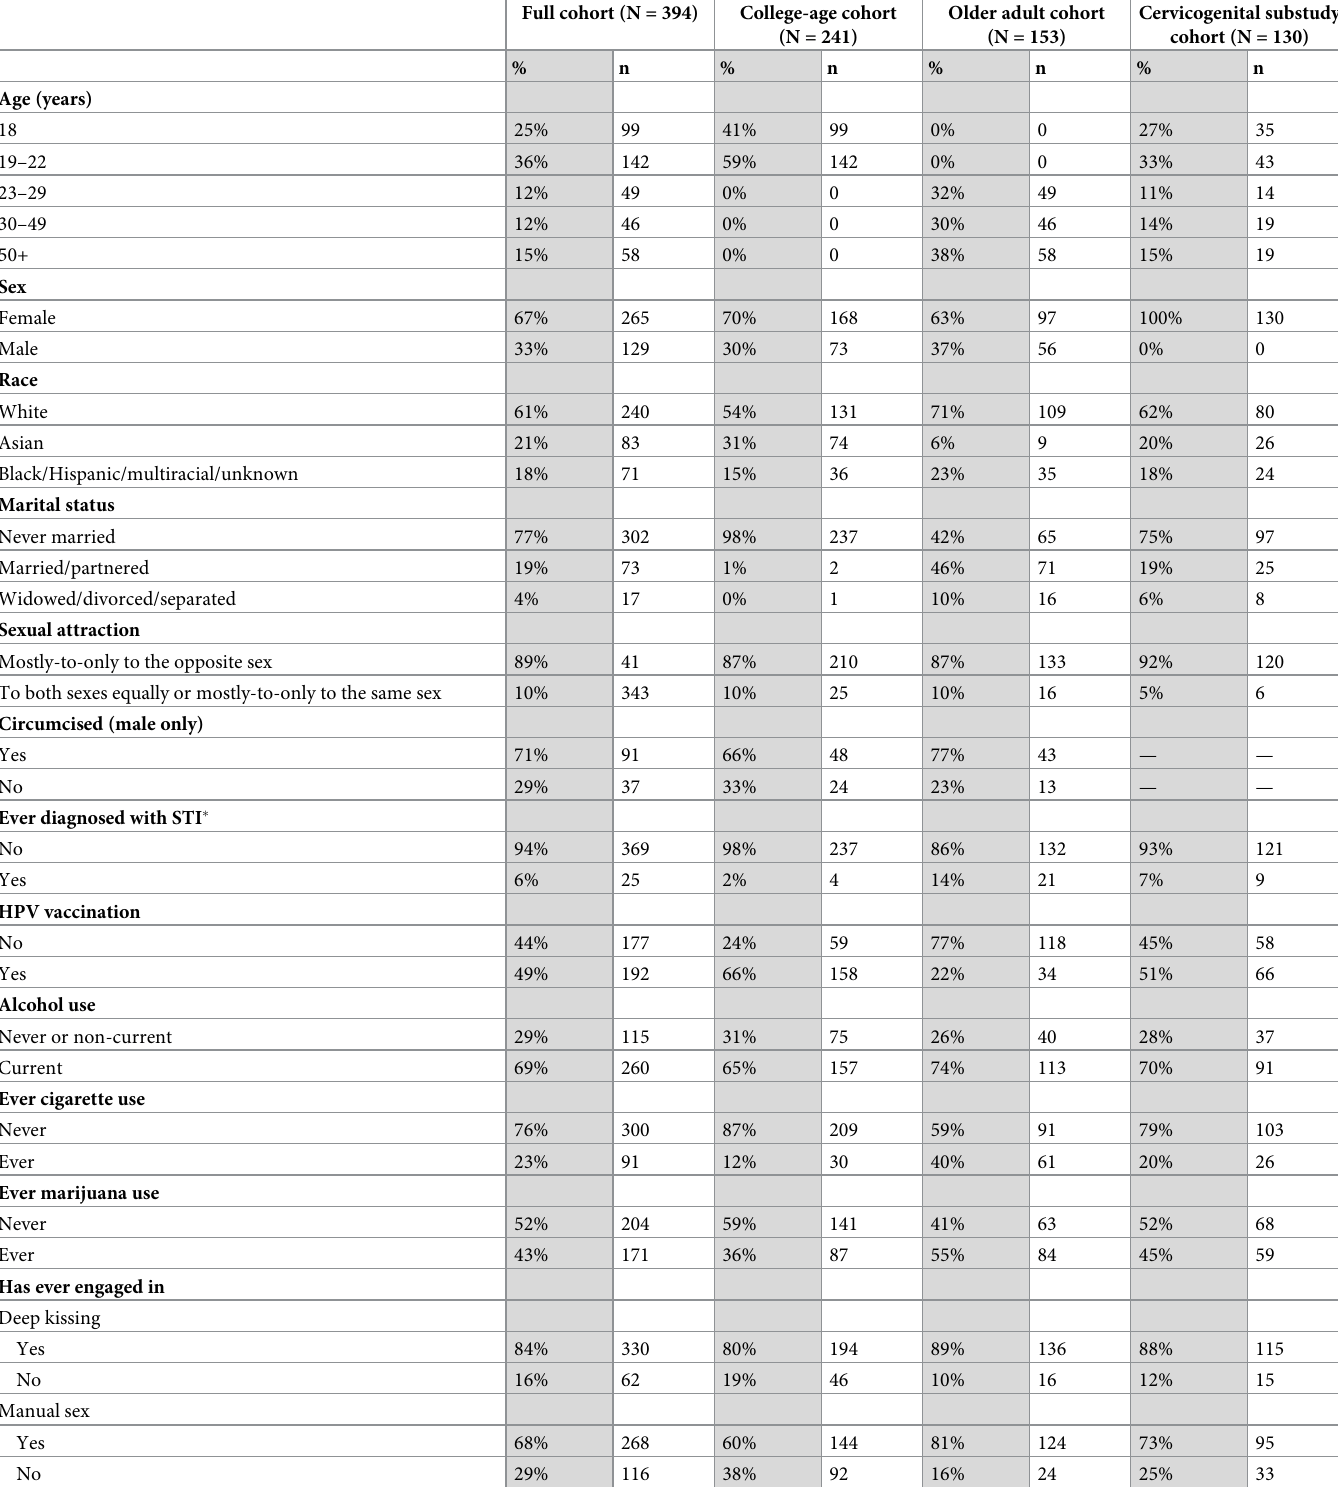
Table 1. Baseline characteristics of participants in the MHOC study (data collected in Ann Arbor, MI, 2015–17, analyzed